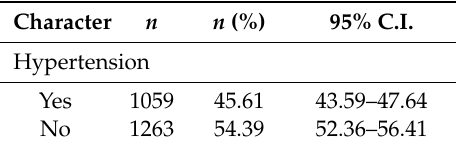
Table 1. Prevalence of hypertension among 2322 Malaysian elderly.